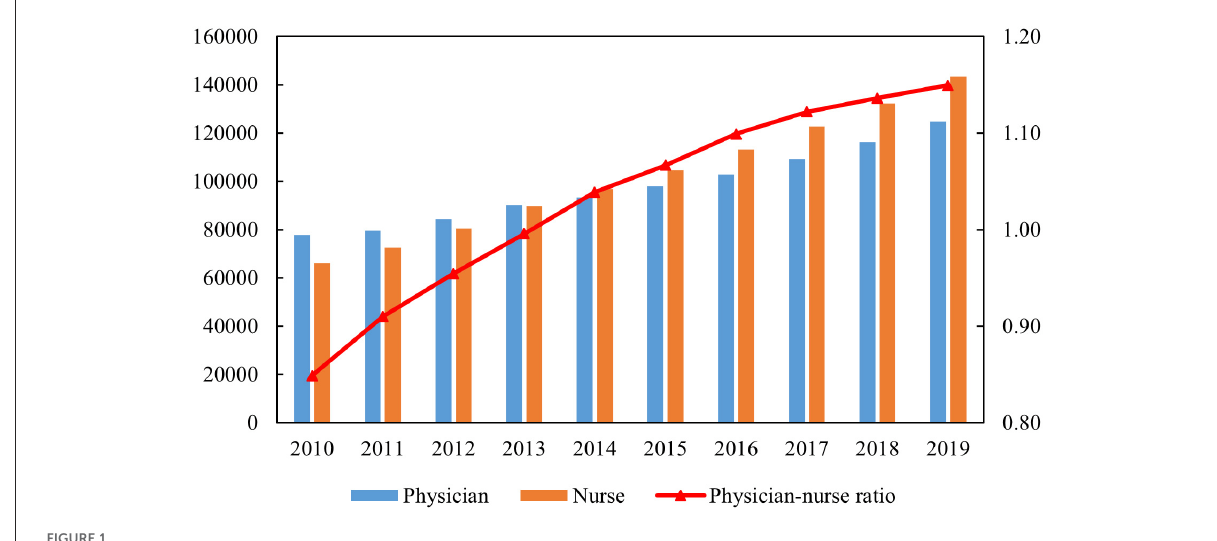
FIGURE1 Physicians, nurses, and physician-to-nurse ratio from 2010 to 2019.